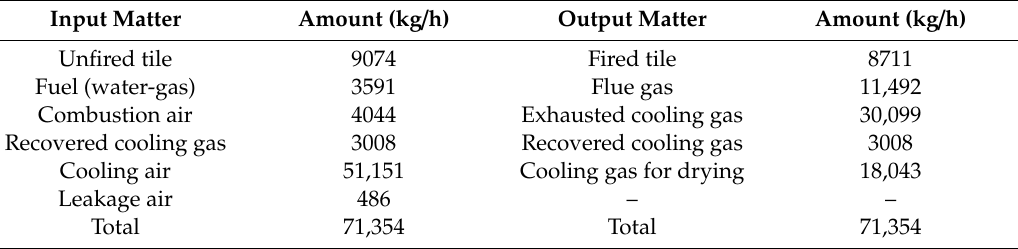
Table 5. Mass balance of the roller kiln.